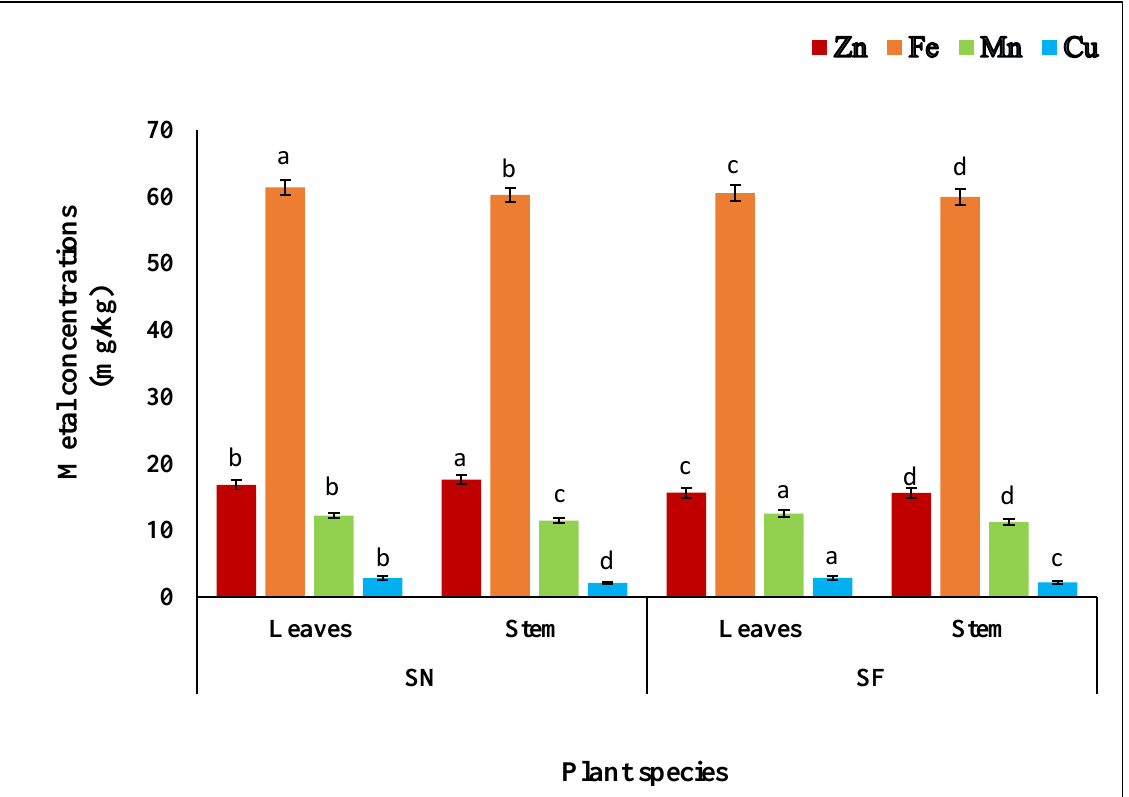
Figure 4. Concentrations of various metal ions in leaves and stem parts of the plants (DMRT), SN = S. nudiflora , SF = S. fruticosa . Note: Statistically significant differences ( p ≤ 0.05) between plant parts are marked with superscripts a, b, c, and d. Table 4. Bioaccumulation factor (BAF) values for metals in leaves and stem of plants species. Species Plant Parts Metals Zn Fe Mn Cu Leaves 0.435 ± 0.17 S. nudiflora Stem Leaves 0.404 ± S. fruticosa